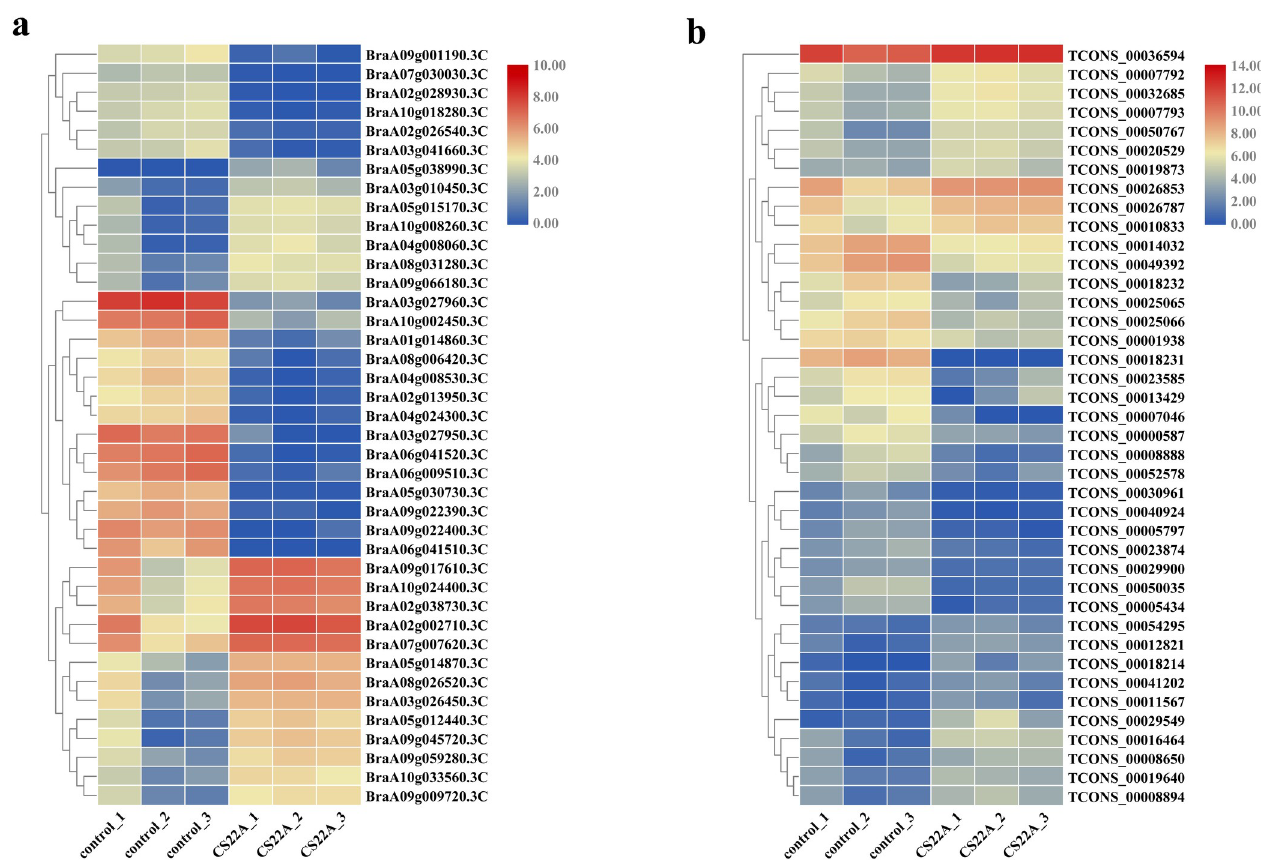
Fig 2. Heatmap of 40 significantly differentially expressed mRNAs (A) and lncRNAs